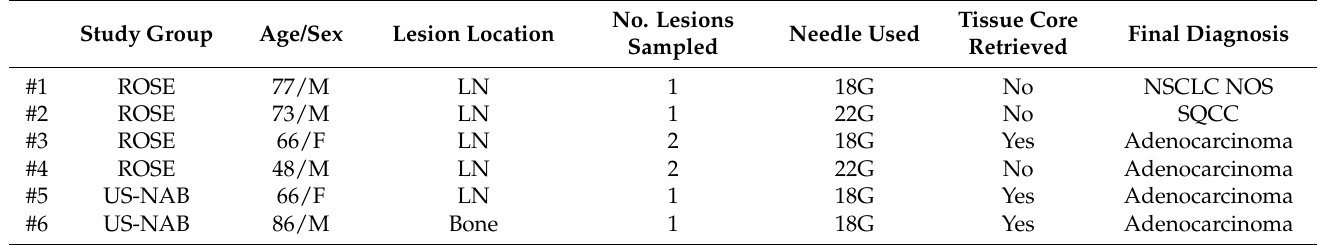
Table 3. Demographic, clinical, and procedural characteristics in the six patients with a non-diagnostic